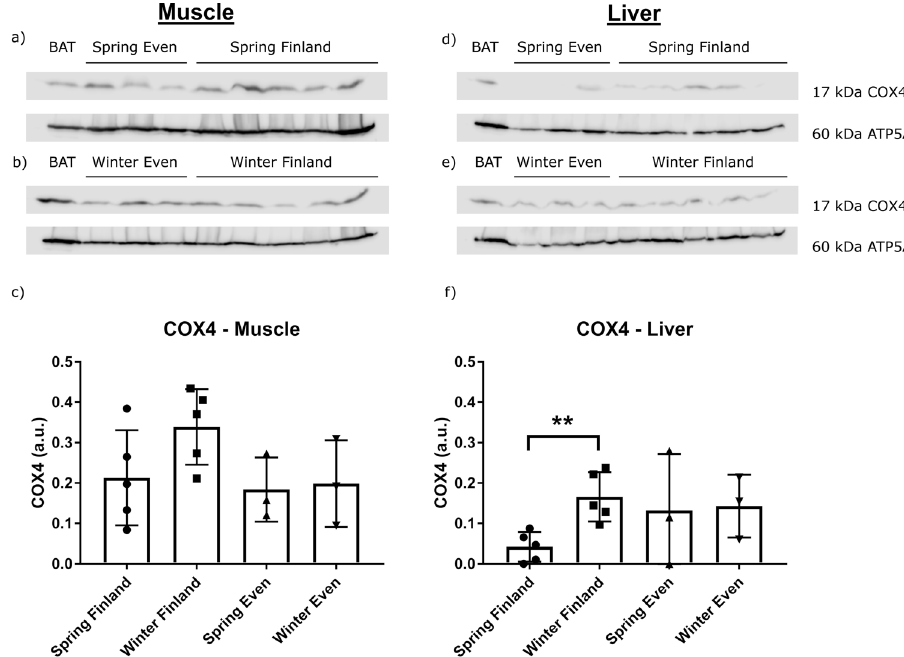
Fig. 5 COX4 expression in each seasons and regions. The western blots and relative expression of COX4 from a – c reindeer muscle ( M. gluteobiceps femoris ) and d – f liver mitochondrial proteins. The upper blots on the left side show COX4 content in the muscle a in spring in Even reindeer ( n = 3) and Finnish reindeer ( n = 5), b in winter in Even reindeer ( n = 3) and Finnish reindeer ( n = 5), and the lower graph shows c their relative expression levels. The upper blots on the right side show COX4 in the liver d in spring in Even reindeer ( n = 3) and Finnish reindeer ( n = 5), e in winter in Even reindeer ( n = 3) and Finnish reindeer ( n = 5), and the lower graph shows f their relative expression levels. Samples contained 10 µ g of mitochondrial protein per lane, except the reindeer BAT (brown adipose tissue) sample with 1 µ g of mitochondrial protein. Mitochondrial ATP synthase (ATP5A) was used as a loading control. The relative expression of COX4 was normalized to ATP5A and presented as mean arbitrary units (a.u.) ± SD ( c , f ). Signi fi cant difference between seasons is indicated with a bar and asterisks (** p ≤